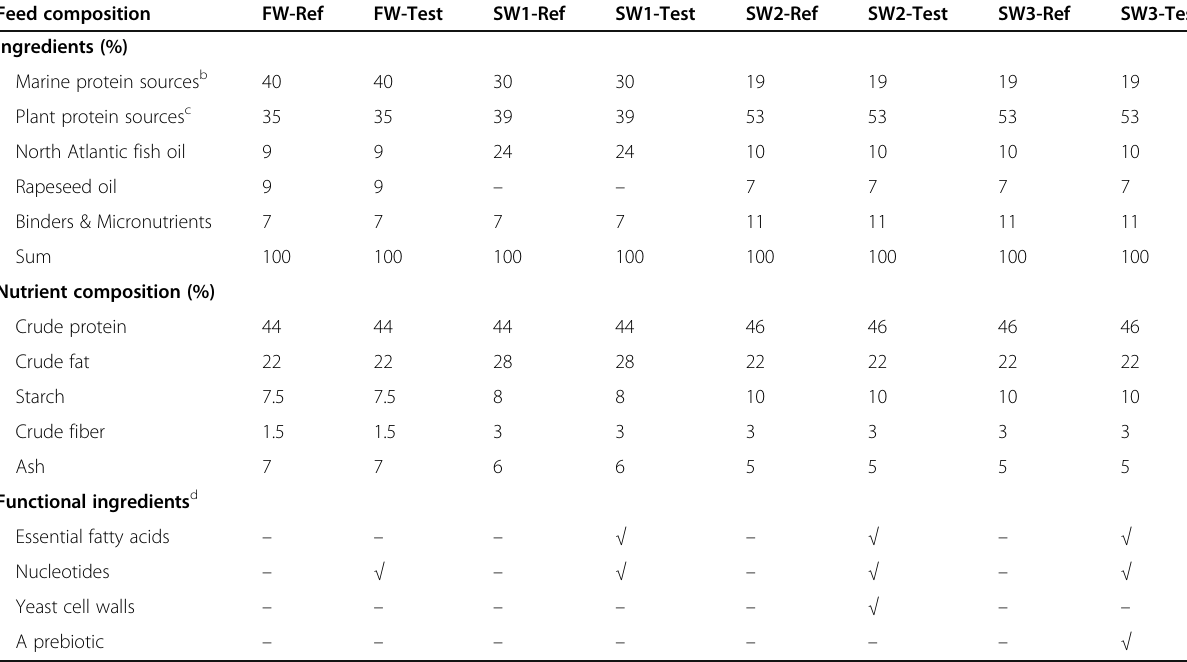
Table 2 Feed composition and formulation of diets during the feeding trial a Feed composition